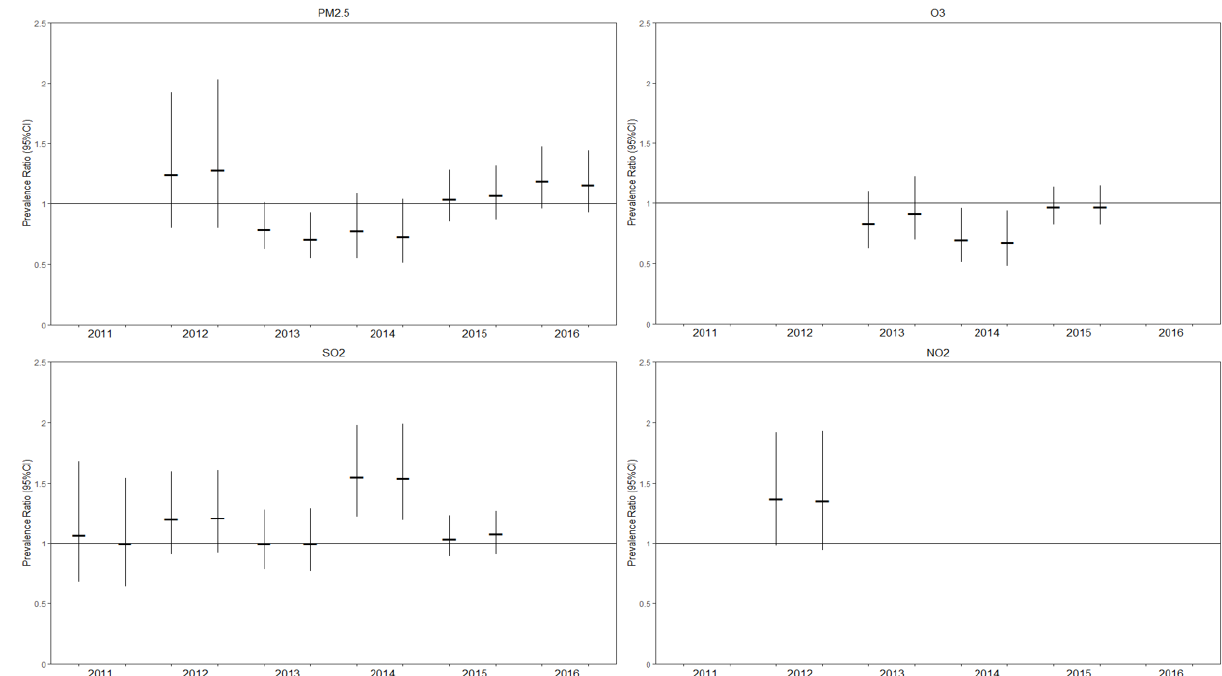
Figure 1. Crude and adjusted estimates of the prevalence ratio between increased outdoor air pollution and depression, with corresponding 95% confidence intervals). The annual crude and adjusted estimates are reported on the left and right, respectively; Potential covariates included: continuous age (centered at 15 years), sex, marital status, total household income, education, employment status, urban versus rural households, cigarette smoking, and chronic illness.